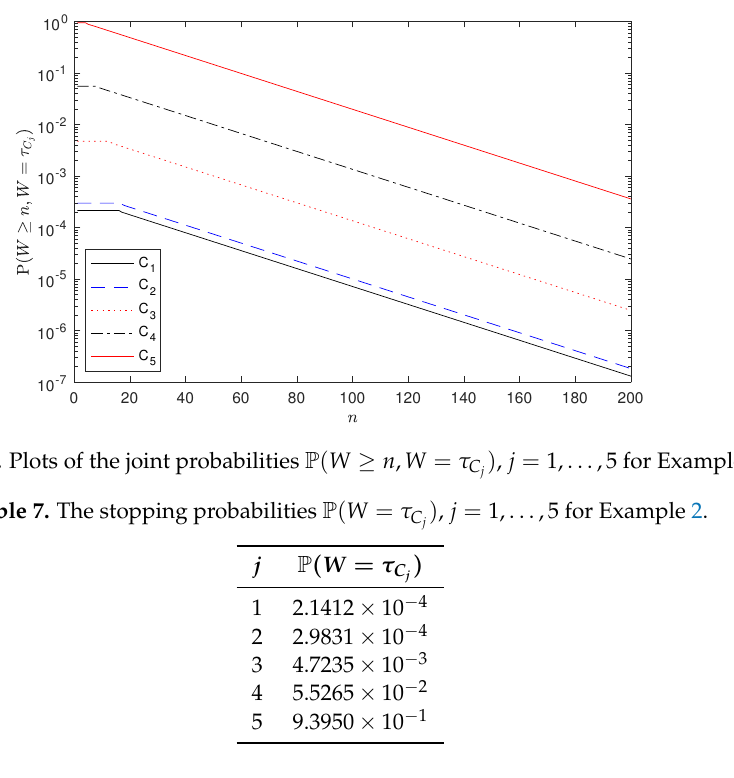
Table 8. The probability mass function P ( W = n ) and tail probability P ( W ≥ n ) for Example